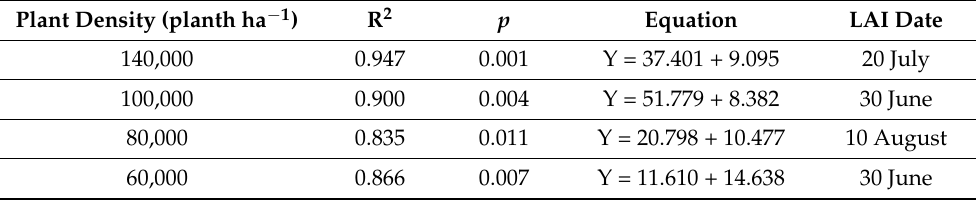
Table 2. Regression model as stepwise selection in prediction of sugar beet root yield by LAI (average of both